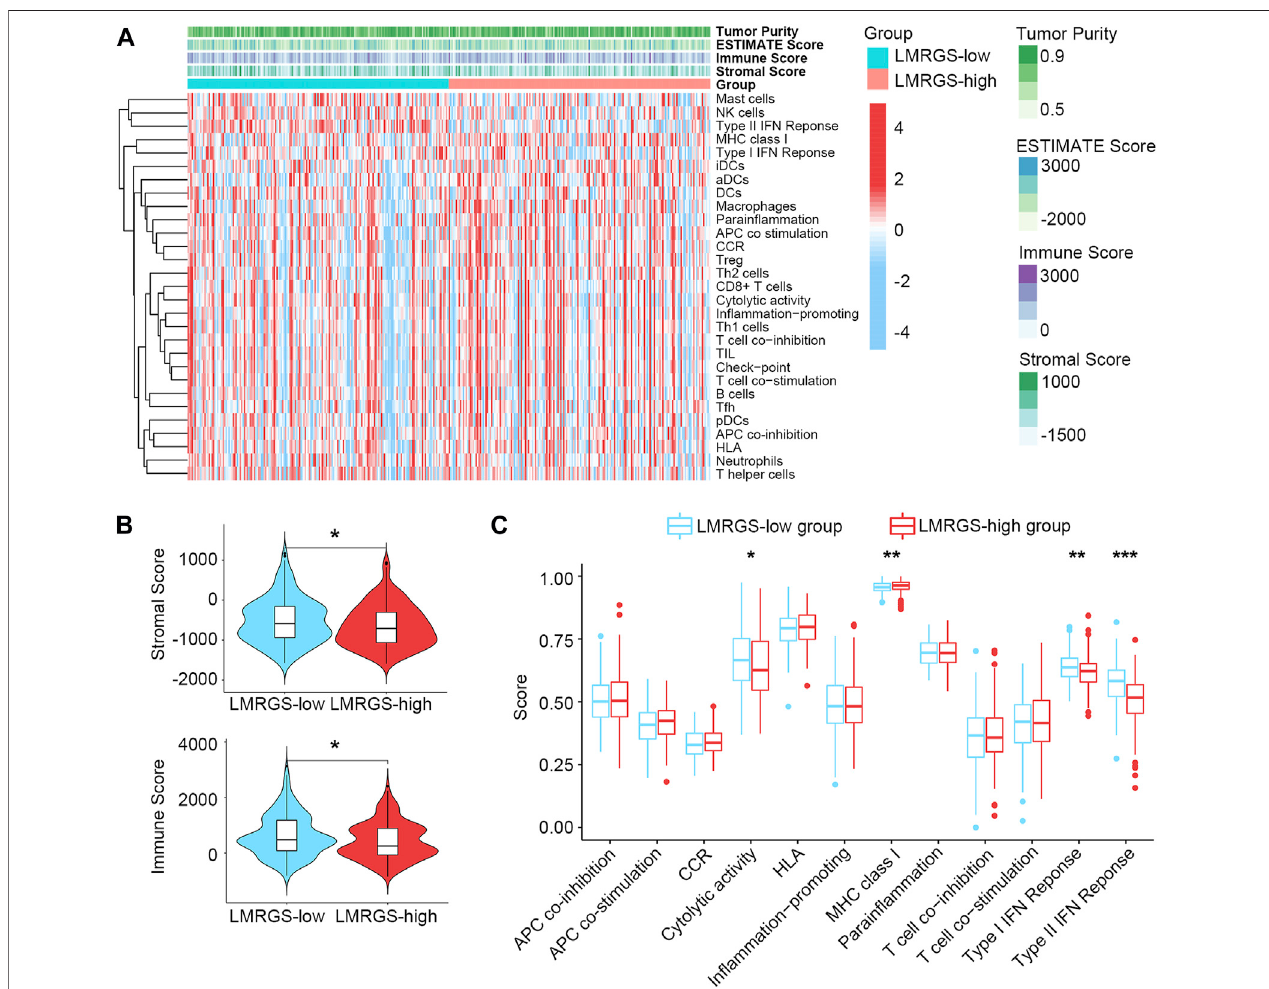
FIGURE 7 | The landscape of TME in HCC. (A) Stromal score and immune activity of all HCC samples. (B) The violin plot showed the difference in stromal scores andimmunescoresbetweenLMRGS-lowandLMRGS-highgroups. (C) Differencesinimmunefunctionbetweenthetwosubgroups.* p < 0.05,** p < 0.01,*** p < 0.001.